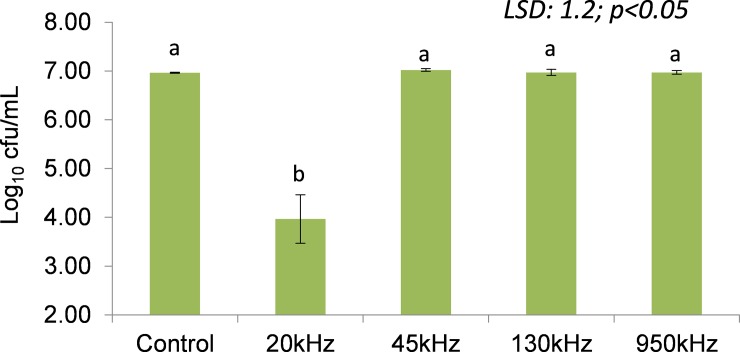
L. sakei population of control (untreated) and surviving population after treatment at various ultrasound frequencies of 20, 45, 130 and 950 kHz.(abColumns with similar letters are significantly different at P<0.05; LSD: Least significant difference).